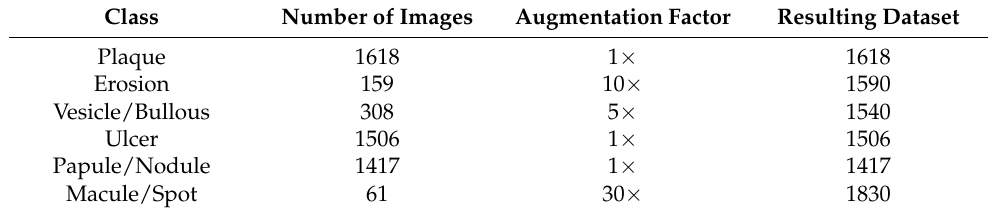
Table 2. Data augmentation of oral elementary